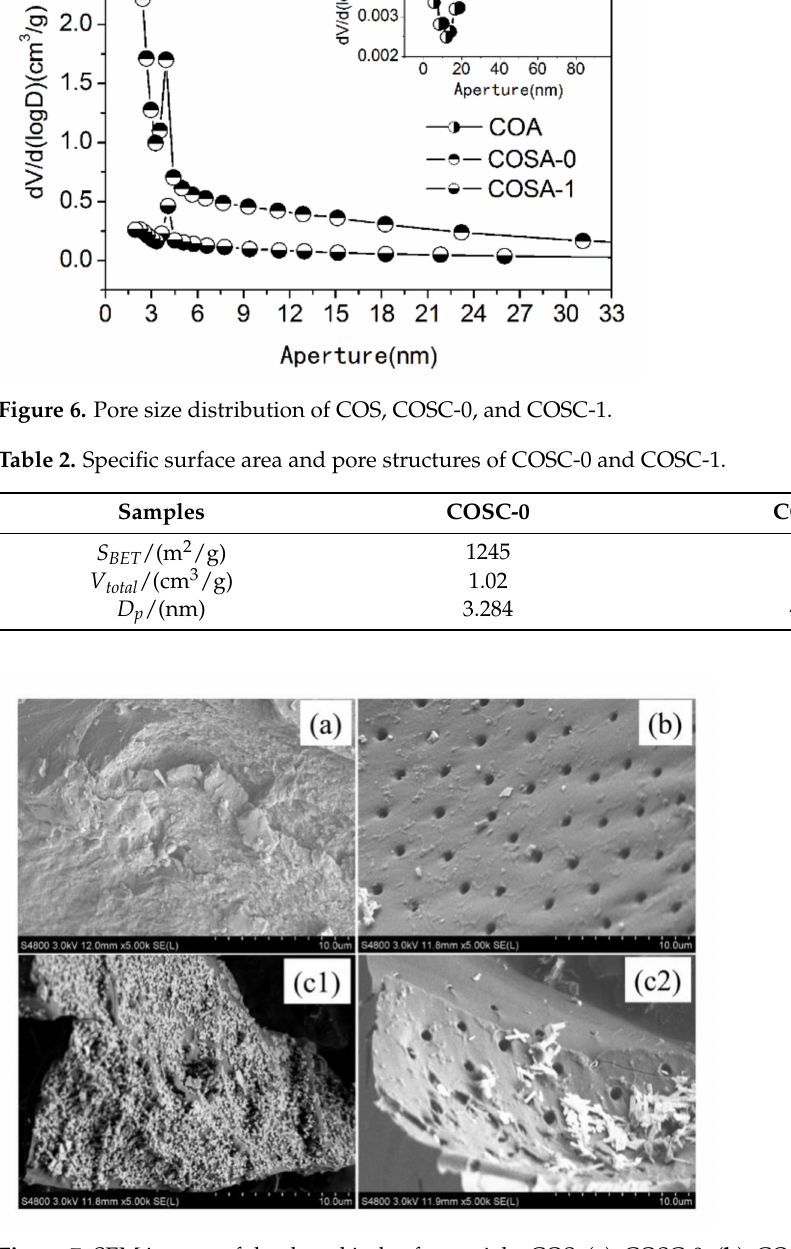
Figure 7. SEM images of the three kinds of materials. COS: ( a ); COSC-0: ( b ); COSC-1: ( c1 ), ( c2